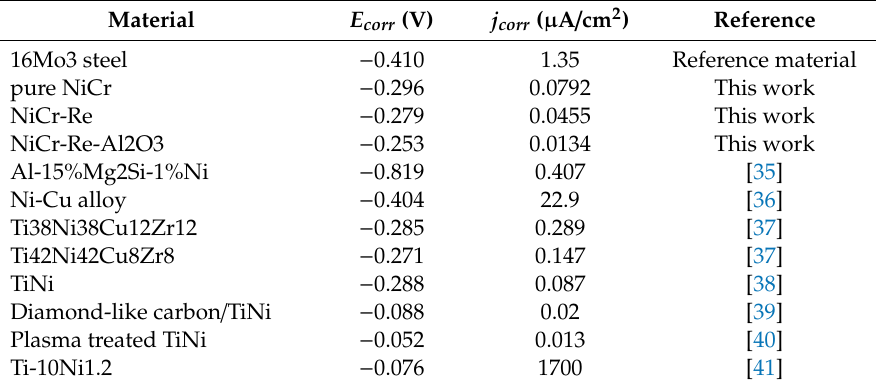
Figure 7. The experimental polarization curves for 16Mo3 steel (black curve), pure NiCr (red curve), NiCr-Re (blue curve), NiCr-Re-Al 2 O 3 (pink curve). Table 2. Results of the corrosion